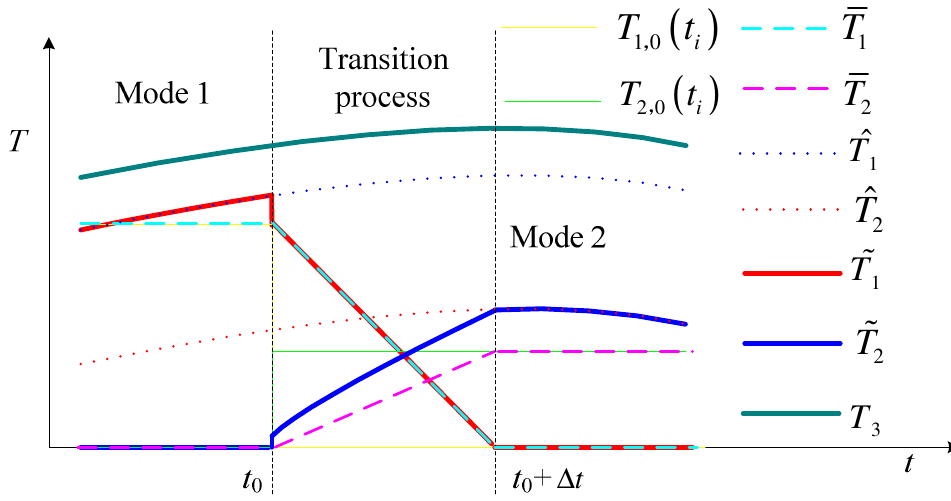
Figure 10. Schematic of mode shifting based on NFBDCS.